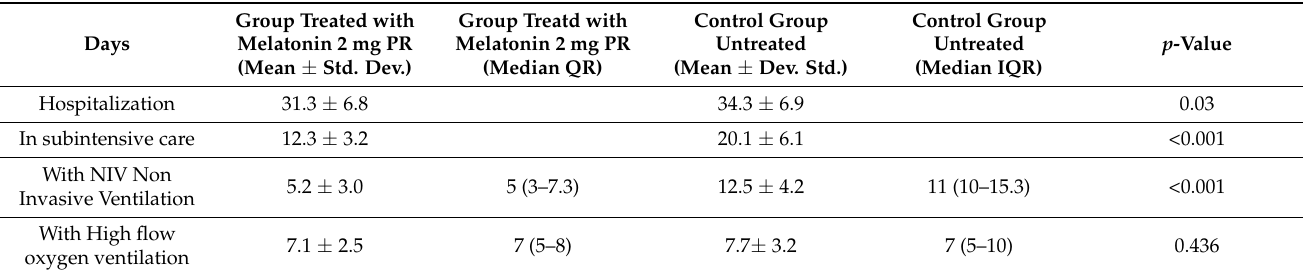
Table 2. Comparison between the two groups on the number of days of total Hospitalization, days of subintenive department, days spent in non invasive ventilation and days with high flow oxygen ventilation.